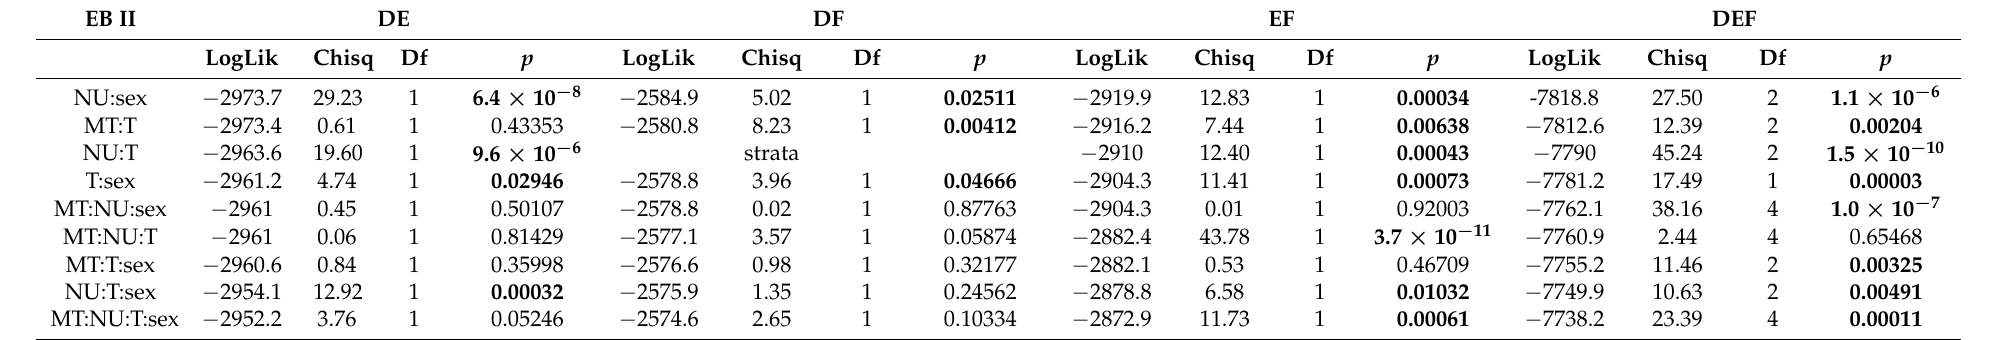
Table 4. The effect of mitochondrial haplotype (MT), nuclear genetic background (NU), sex, temperature (T) and their interactions on desiccation resistance